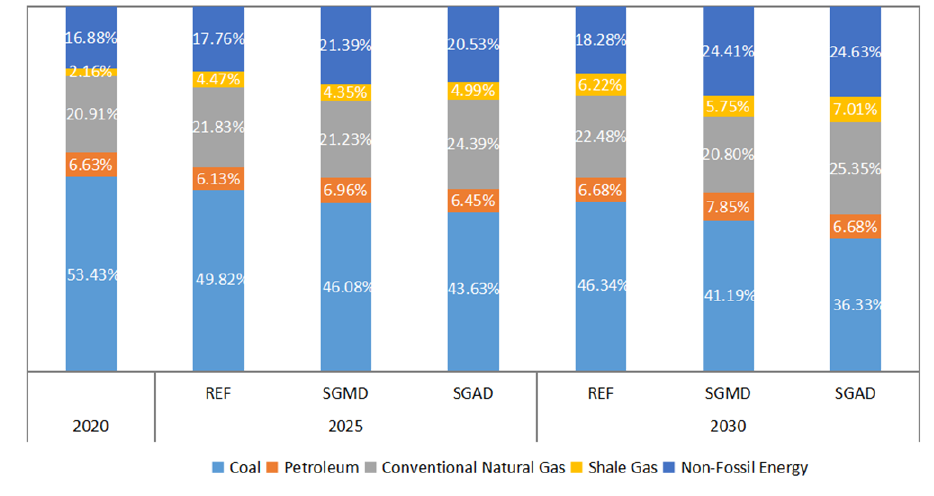
Figure 7. Primary energy consumption structure.